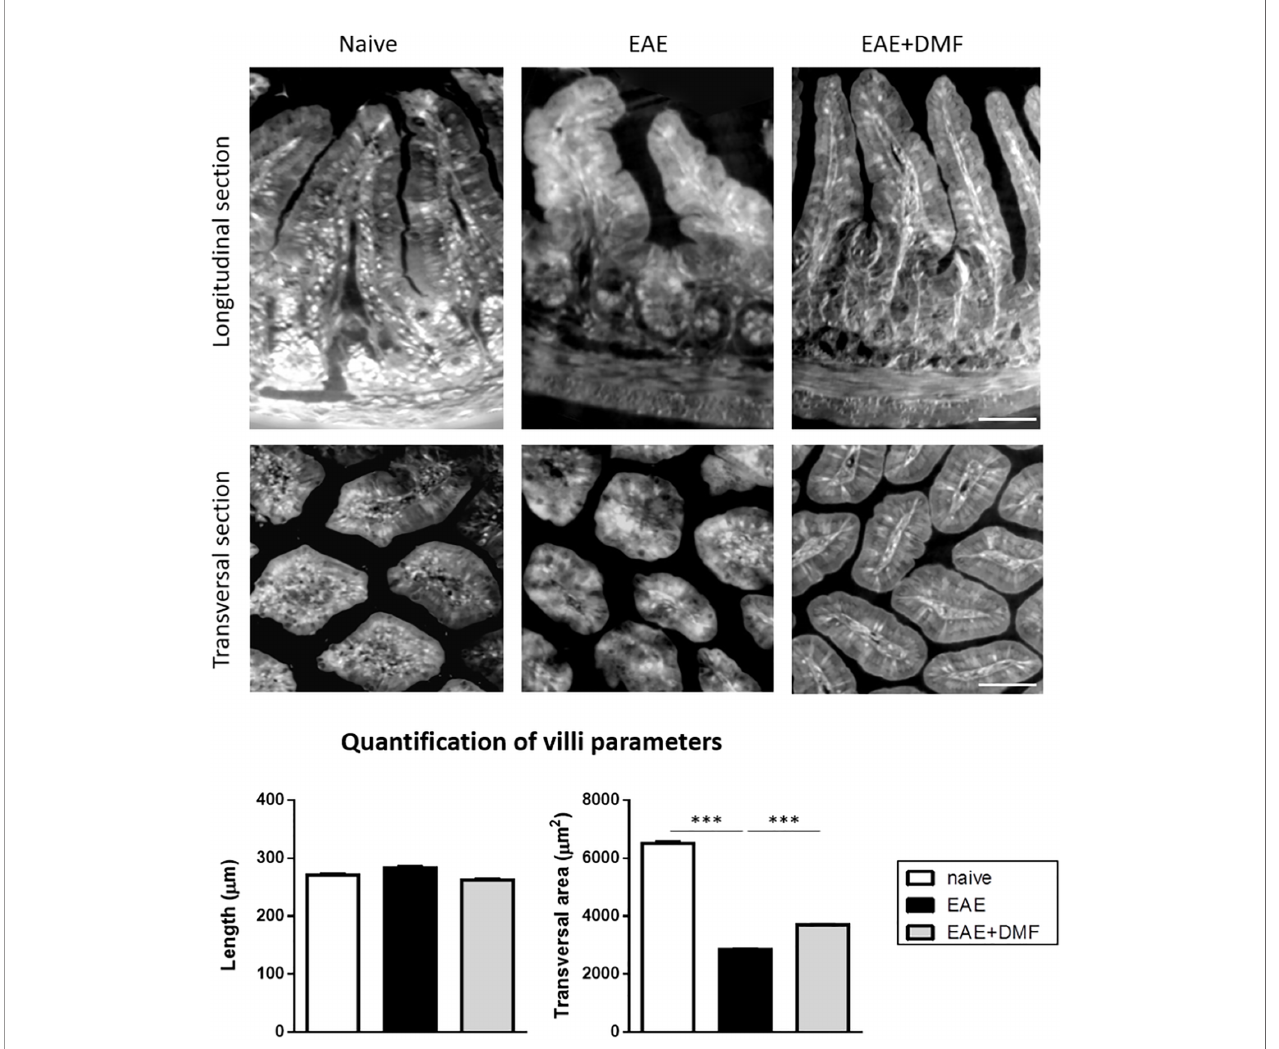
FIGURE 4 | DMF treatment does not worsen the morphological alterations induced by EAE at the level of the ileum. Ilea were isolated from naïve mice and at 4 d post onset from EAE-affected mice treated or not with DMF. Top panels show representative XPCT images (longitudinal and transversal sections) of ileum in naïve, EAE-affected, and EAE-affected DMF-treated mice. Bottom panels show the quanti fi cation of the morphological parameters (length and transversal area) performed using ImageJ software (as described in Methods ) for at least 120 villi/mouse (N = 3 mice per condition). Average clinical scores of mice at time of the analysis: WT- EAE-affected mice: 3 ± 0.17; WT-EAE-affected mice treated with DMF: 2.75 ± 0.11. Scale bars: 50 m m. Results are shown as mean ± SEM. *** P <